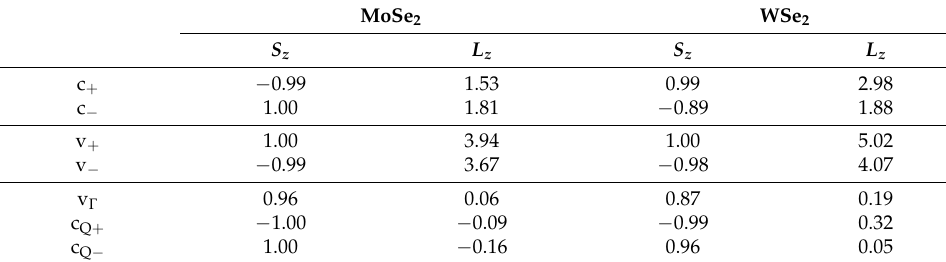
Table 3. Calculated values of S z and L z for the relevant energy bands in monolayers.